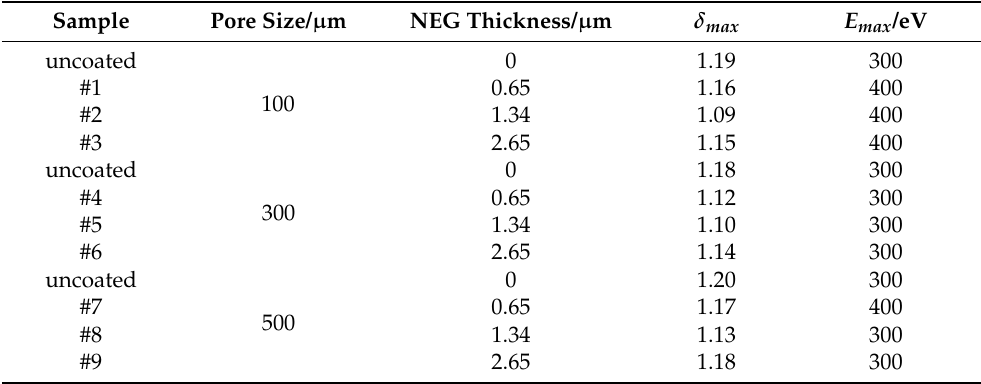
Table 3. The SEY properties of samples used in this